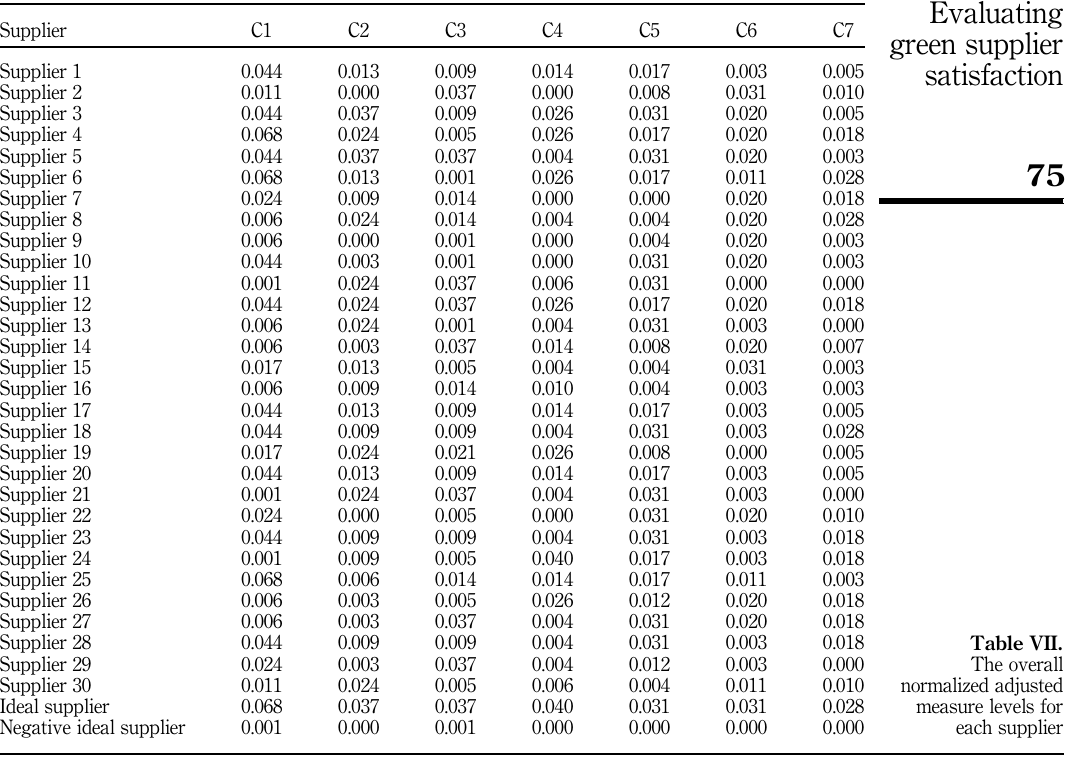
normalized adjusted measure levels for each